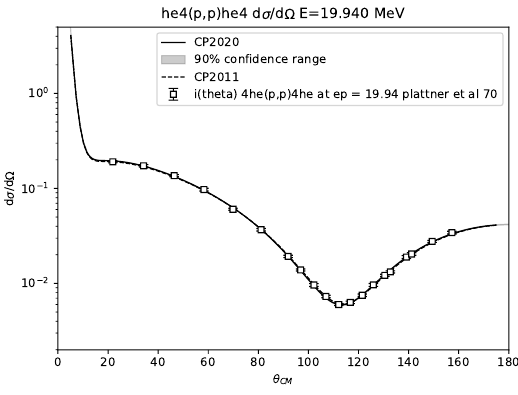
Figure 8. The angular distribution for 4 He( p , p ) 4 He for deuteron incident laboratory energy 19.94 MeV of the unpolarized differ- ential cross section in the center of mass as a function of the center of mass angle θ cm . The evaluation is shown by the solid curve. The gray band is the 90% confidence interval determined as described in the